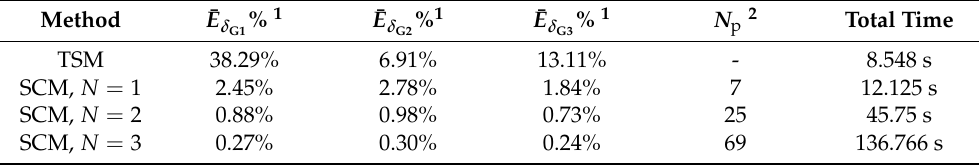
Table 1. Computation time and approxiamtion error of the SCM and TSM in fault 1.